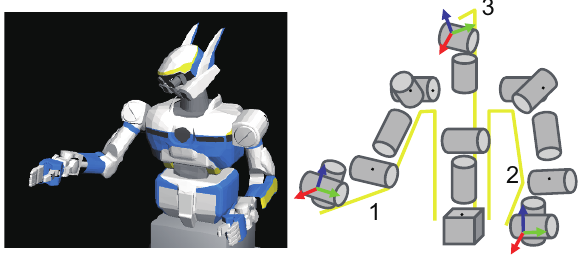
Figure 5. Kinematics link model of a humanoid robot